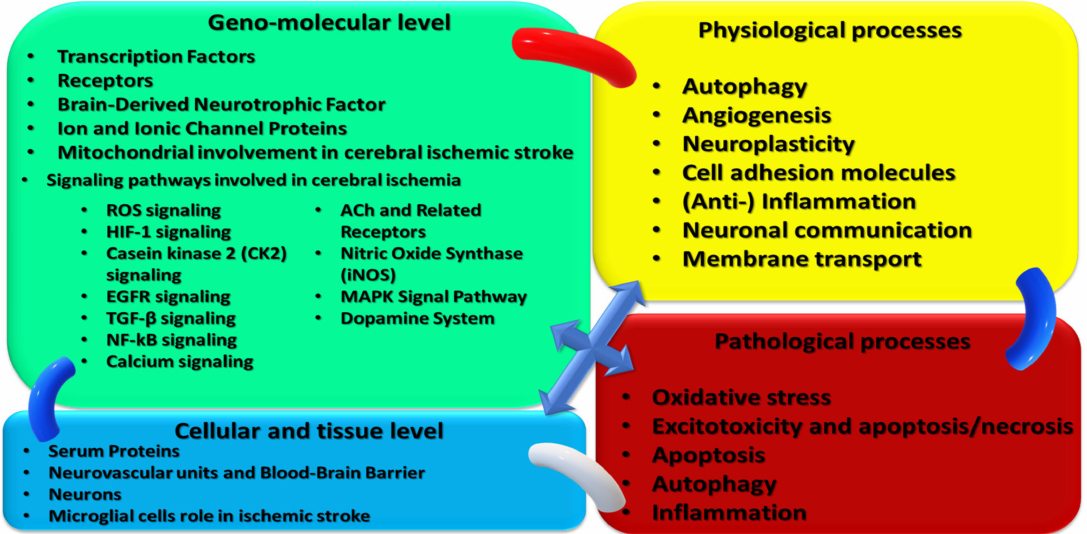
Figure 1. Integrative synoptic diagram of basic intimate structures and physiological/pathological processes targeted by non-invasive, non-pharmacological therapeutic/rehabilitative interventions in acute Ischemic